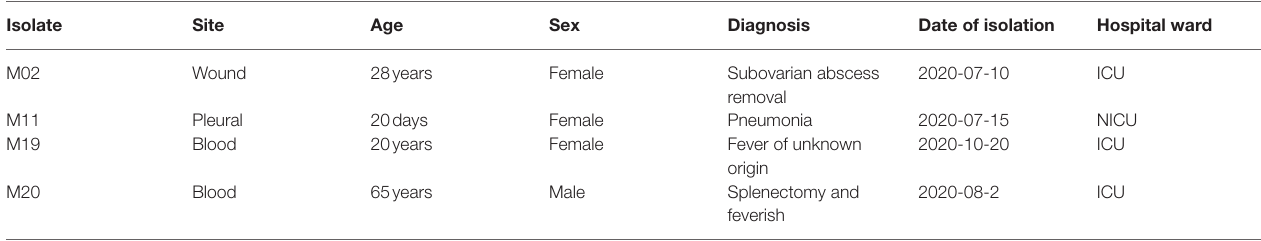
TABLE 1 | Clinical data of the four NDM-producing Acinetobacter baumannii . Isolate Site